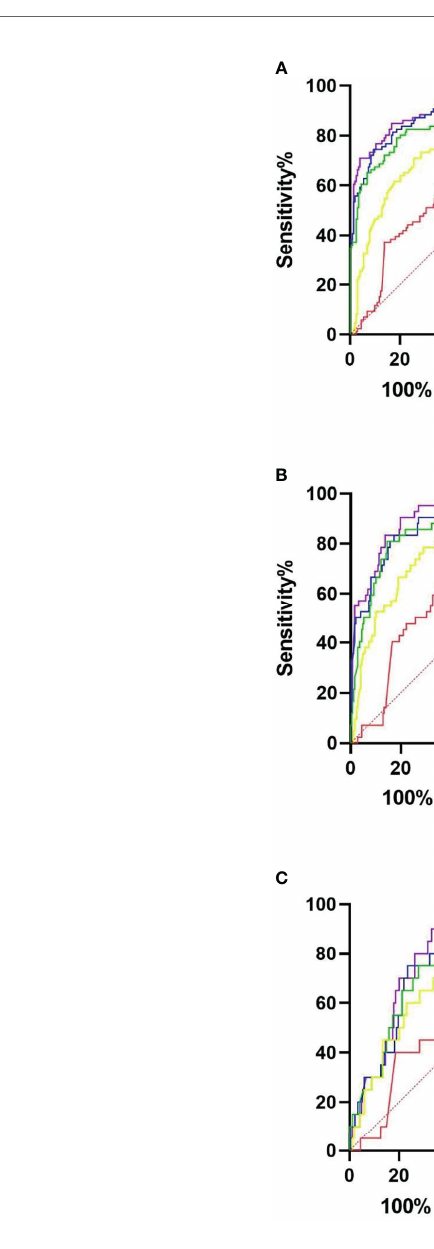
FIGURE 3 | Diagnostic bene fi t of the variations in antithyroglobulin antibody (TgAb) relative to the preoperative levels in predicting the clinical outcome during receiver operating characteristic (ROC) analyses. (A) Tumour-free versus uncertain + incomplete biochemical response + structural disease at the end of follow-up. (B) Tumour free + uncertain versus incomplete biochemical response + structural disease at the end of follow-up. (C) Tumour-free + uncertain + incomplete biochemical response versus structural disease at the end of